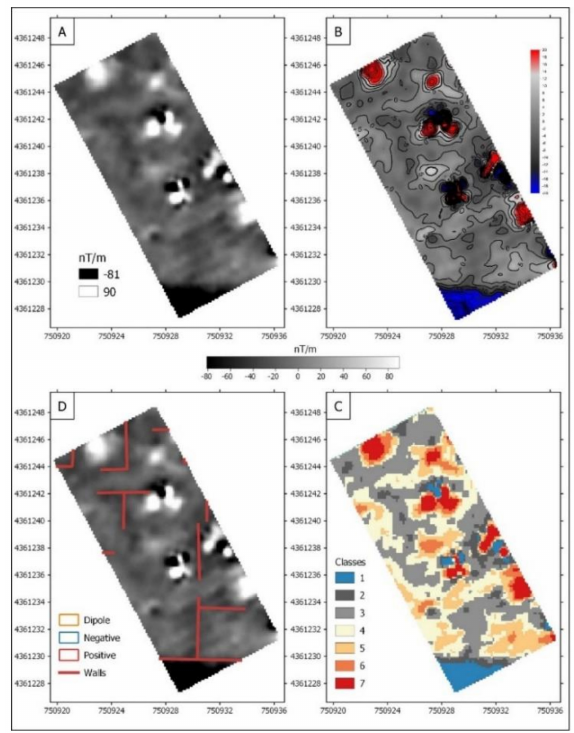
Figure 3. Gradiometer response map. ( A ) Vertical gradient in nT / m. ( B ) Vertical gradient with 5 nT / m interval contour lines and ± 15 nT / m peaks shown in red / blue. ( C ) Map of interpreted amplitude values, defined as follow: Class 1 (high-intensity negative anomaly), 2–3 (low- to medium-intensity negative area, corresponding to walls), 4 (undetermined), 5–6 (low- to medium-intensity positive area), and 7 (high-intensity positive anomaly). ( D ) Map of identified gradient values and anomalies corresponding to